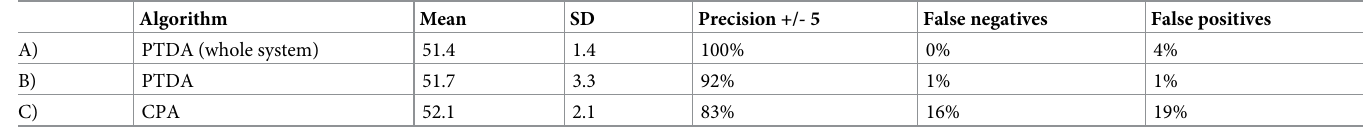
Table 1. Comparison of the PTDA when (A) the 5 five time series per simulation are assessed simultaneously, i.e., the whole system is taken into consideration, when (B) the time series are assessed independently, and (C) when the common CPA algorithm (with respect to the change of the mean) is applied to the single time series. Based on the 300 simulated time series from 60 simulation runs with an induced change at T = 50, the table shows the mean change point of the algorithms, the standard deviation (SD), the precision, the false negative rate, and the false positive rate. Both algorithms are able to correctly detect the TP in most cases, but the per- centages of false negative and false positive findings are much lower in the